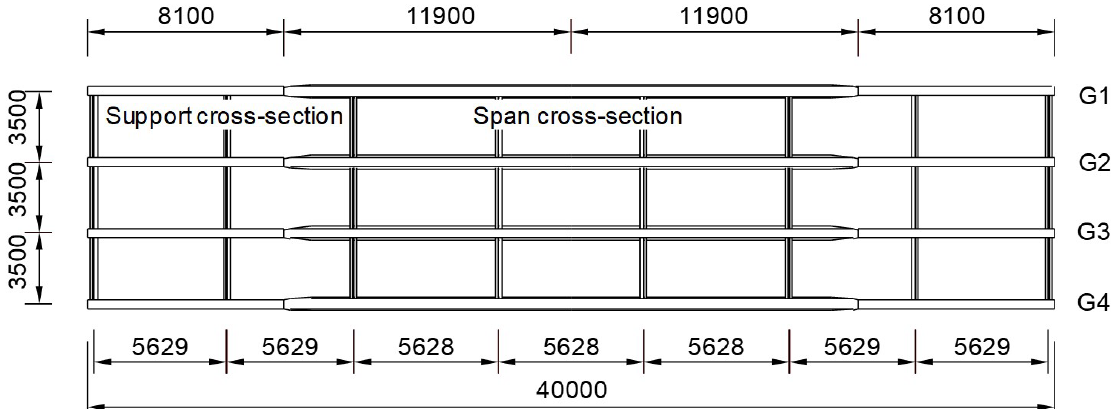
Figure 5. Bridge steel girder’s top view: units in millimetres